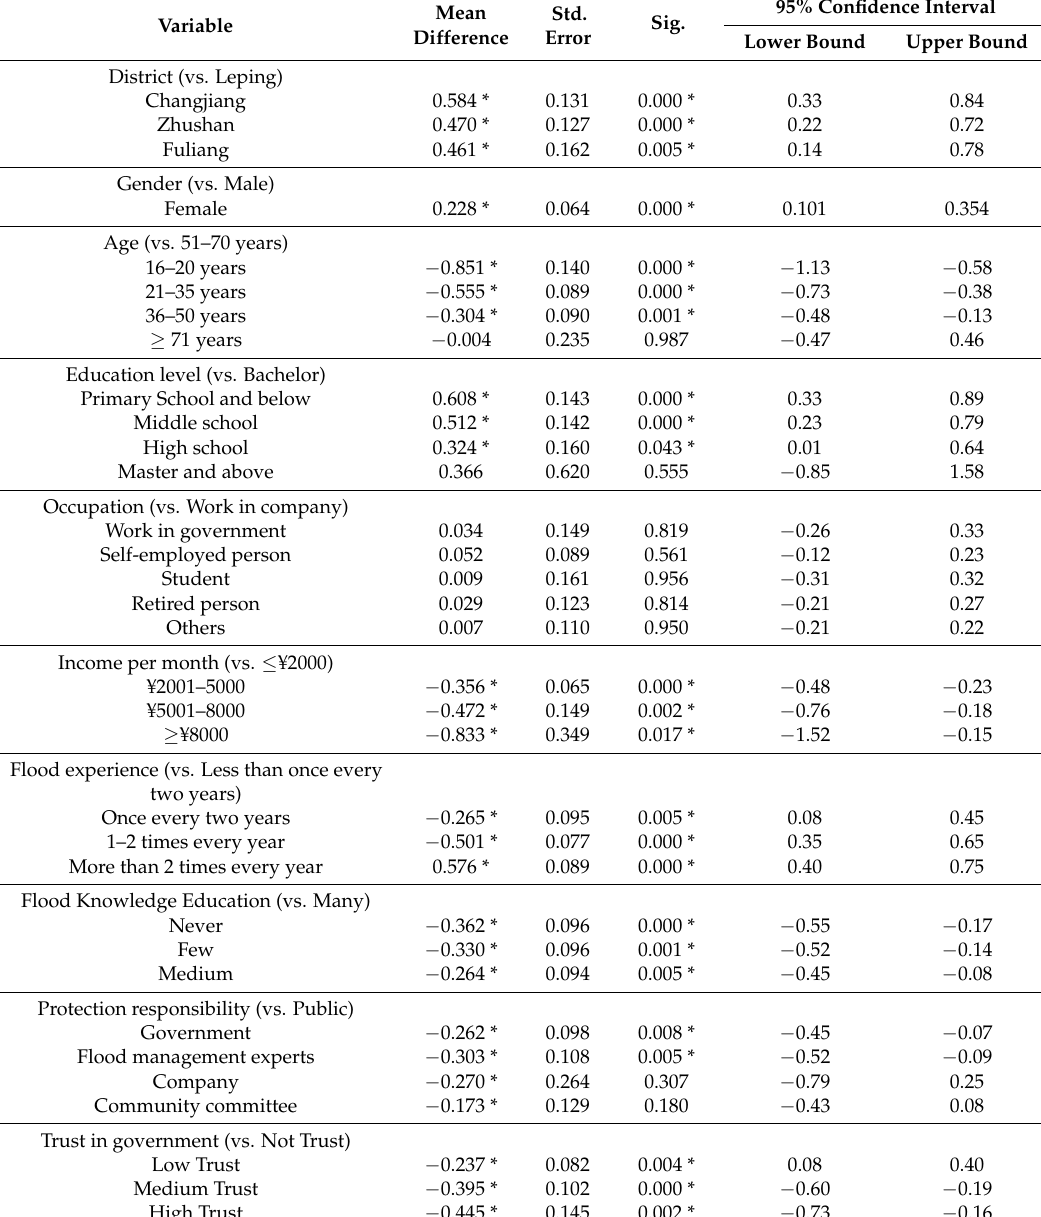
Table 6. Multiple Comparisons for factors affecting public flood risk perception.